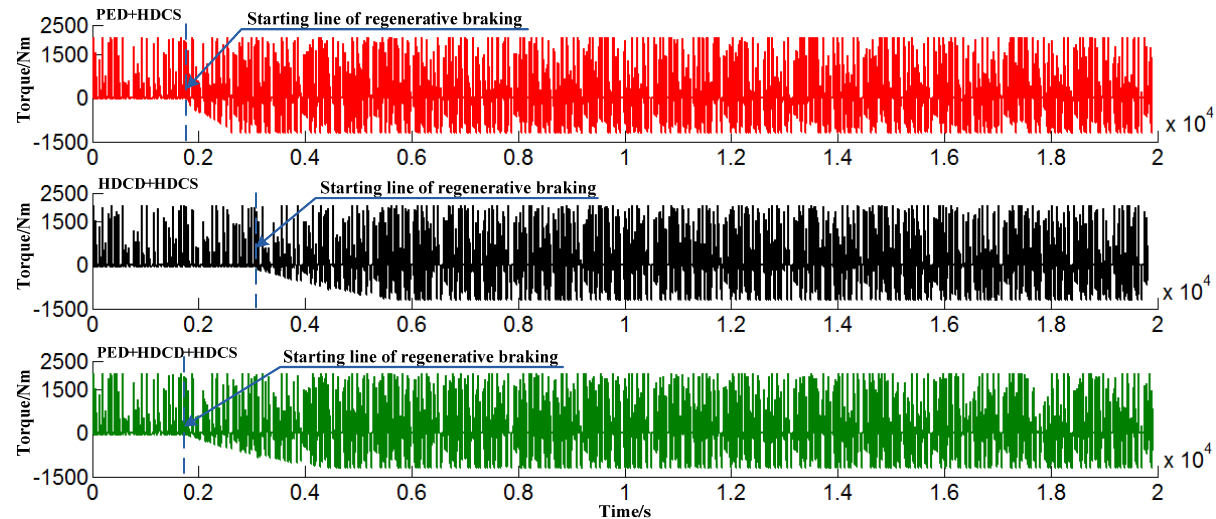
Figure 14. The TM torque profiles under different